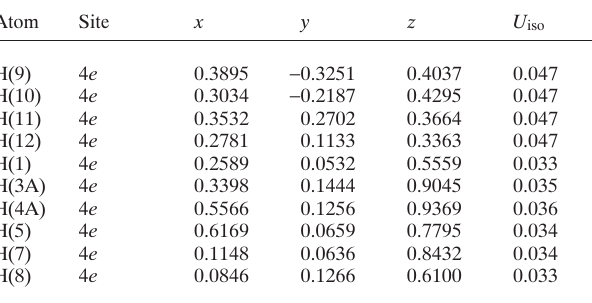
Table 2. Atomic coordinates and displacement parameters (in Å 2 )